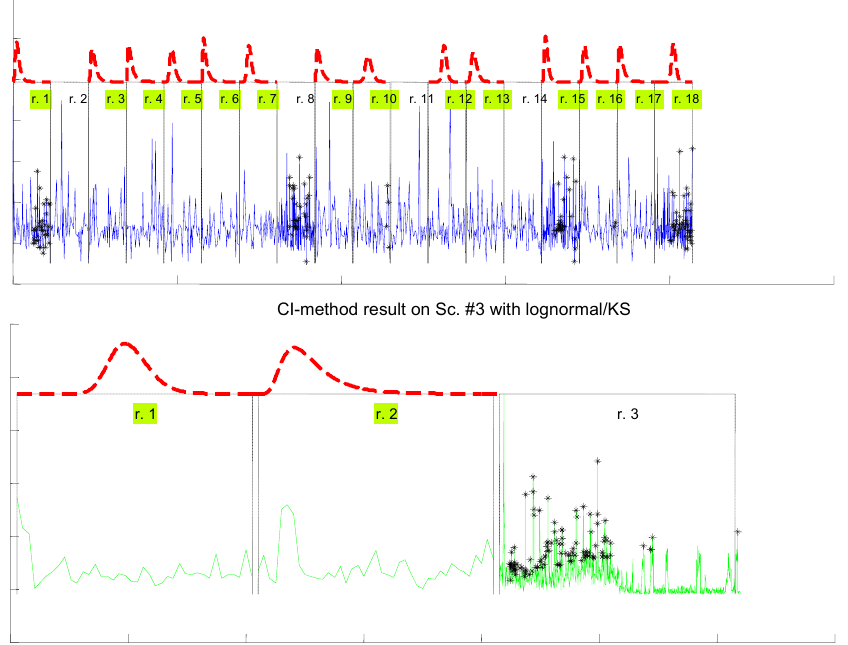
Figure 7. Plots of the detection of outliers, bursts and regime changes by our method of confidence intervals (CI) with different parametrical distributions. Black asterisks correspond to the detected bursts and outliers. All the models successfully found for the regimes detected by the algorithm (red lines over the green-marked segments) are depicted with the same aspect ratio in order to provide a fair comparison of their shapes. The delays below them have been stretched